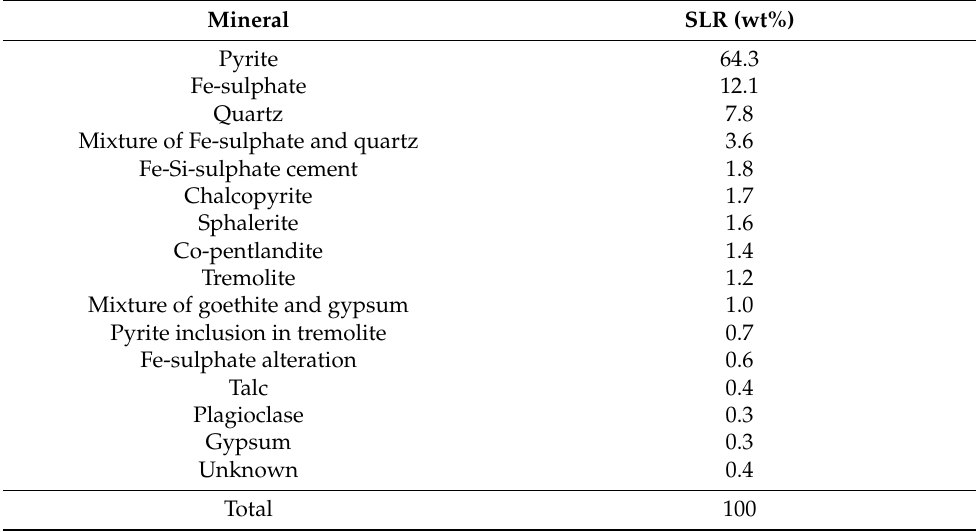
Table 5. Mineralogical composition of mixed solid leach residue